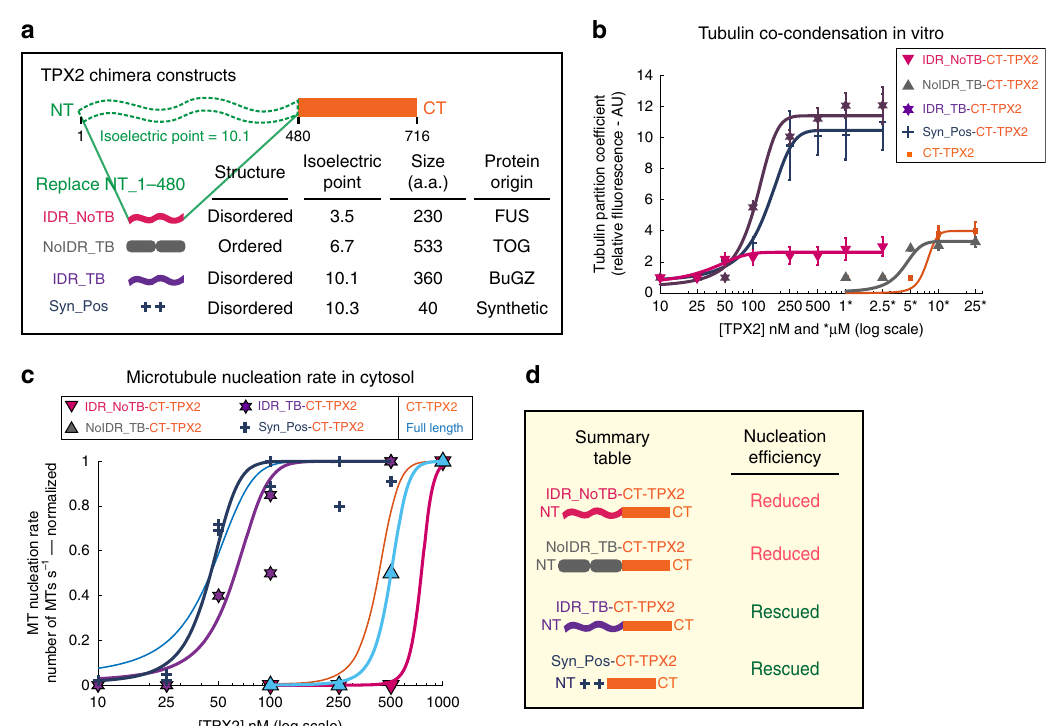
Fig. 5 TPX2-tubulin co-condensation underlies ef fi cient branching MT nucleation. a Schematic of chimera design: the endogenous N-terminal 1 – 480aa of TPX2 are replaced with exogenous domains containing distinct features shown in table. b Quanti fi cation of tubulin partition coef fi cient as a function of TPX2 concentration. For partition coef fi cient graphs, mean values (points) with ±1 SD as error bars from a representative experiment are plotted and a line was fi t; n of condensates per condition are: IDR_NoTB — 111, 80, 142, 99, 198, and 198 for 50, 100, 250, 500 nM, 1, and 2.5 μ M [TPX2/TB], respectively; NoIDR_TB — 198, 136, and 86 for 5, 10, and 25 μ M [TPX2/TB], respectively; IDR_TB — 87, 122, 153, 198, and 198 for 100, 250, 500 nM, 1, and 2.5 μ M [TPX2/TB], respectively; Syn_Pos — 326, 302, 100, 261, 270, and 323 for 50, 100, 250, 500 nM, 1 and 2.5 μ M [TPX2/TB], respectively. See also Supplementary Figs. 6a, c, f and 7e for partition coef fi cients of TPX2. c Rate of MT nucleation as a function of TPX2 concentration for indicated constructs. Rates for each concentration of a given construct are normalized to the maximum rate of that construct (absolute maximum rates between all constructs are in a ±2× range). Lines of best fi t shown. Data for full length (Figs. 2e and 3d) and CT_TPX2 (Fig. 4d) were previously shown. See also Supplementary Fig. 6b, d, e, g and 7f for individual rate curves and Supplementary Movies S7 and S8. Source data are provided as a Source Data fi le. d Summary table of results.MT nucleation ef fi ciencies are relative to full-length